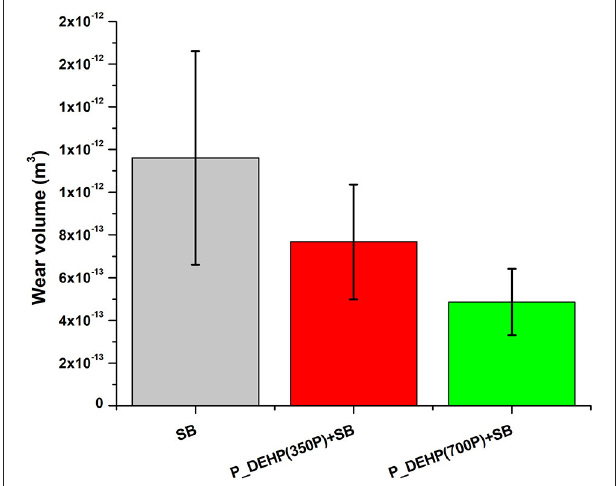
FIGURE 2 | A plot of average CoF for the 60min test of oils containing additives, SB, P_DEHP(350P) + SB, and P_DEHP(700P) + SB.